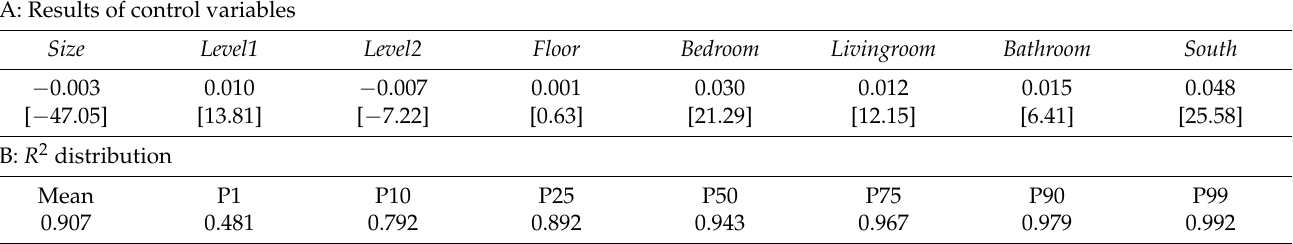
Table 3. Control variables and R 2